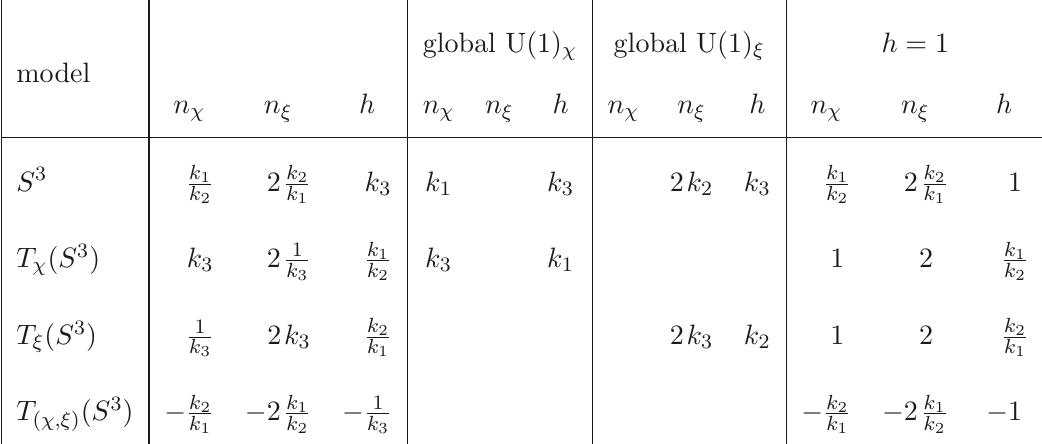
Table 1 . Summary of geometric and NS-charges for the three-sphere orbifold and its T-dual configurations. In the first column, T ⋆ ( S 3 ) denotes the T-dual of S 3 orbifold along the direction(s) ⋆ . For a globally-defined U(1) χ isometry k 2 = 1 is needed, and we have displayed only the integer charges. Similarly, for a globally-defined U(1) ξ isometry k 1 = 1 has to be required and we again only showed the integer